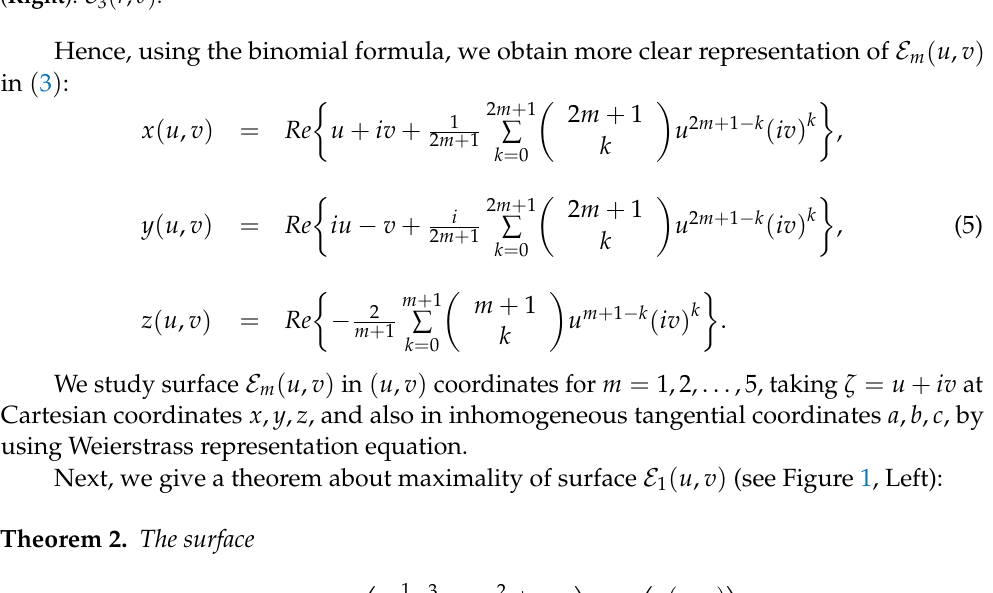
Figure 1. Enneper maximal surfaces, and its top views ( Left ): E 1 ( r , θ ) , ( Middle ): E 2 ( r , θ ) , ( Right ): E 3 ( r , θ )